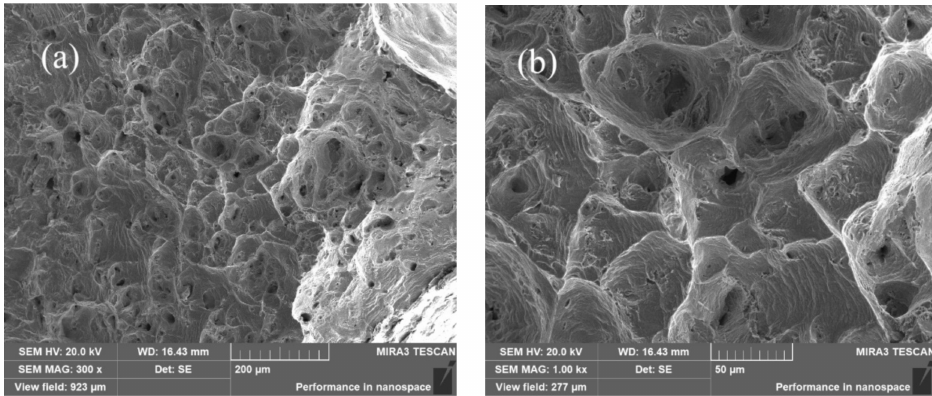
Figure 5. Scanning electron microscopy (SEM) images of the fracture surface of Co 32 Cr 28 Ni 32 . 94 Al 4 . 06 Ti 3 . ( a ) magnification of 300 times; ( b ) magnification of 1000